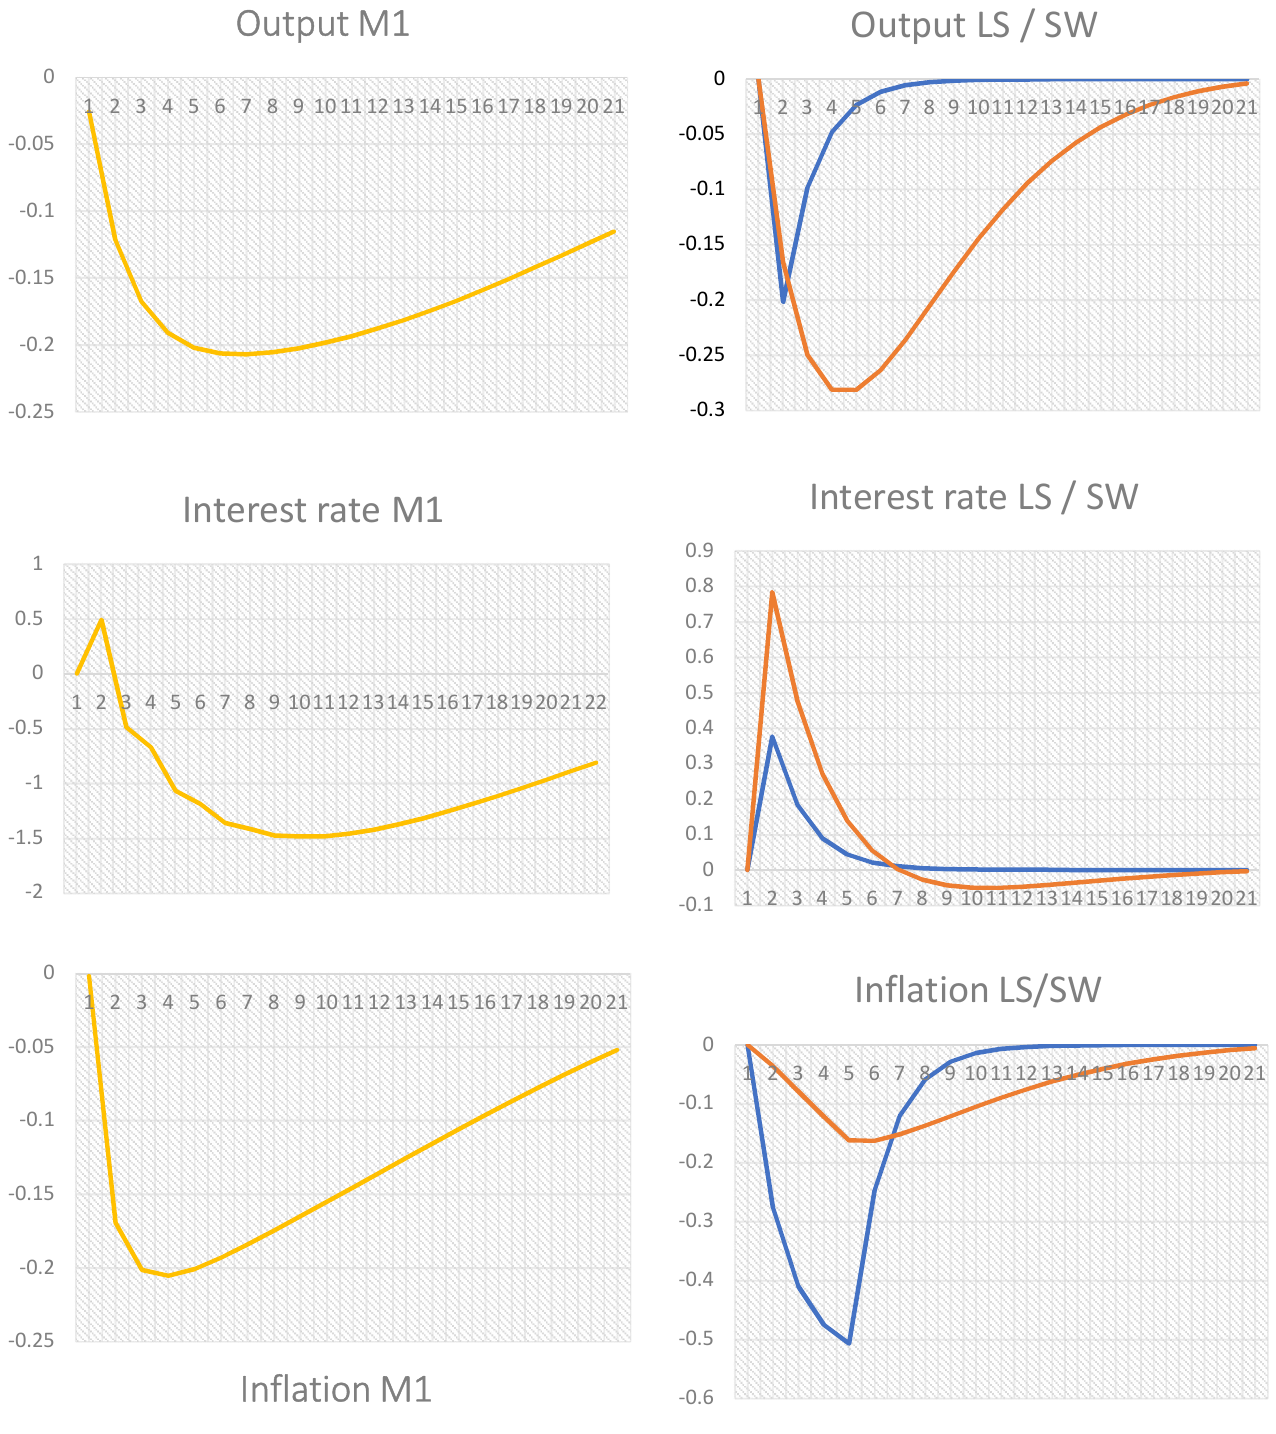
Figure 8. Comparison of M1 and LS/SW. Color blue is for Lubik and Schorfheide (2007) [39] and orange is for Smets and Wouters (2007) [21].